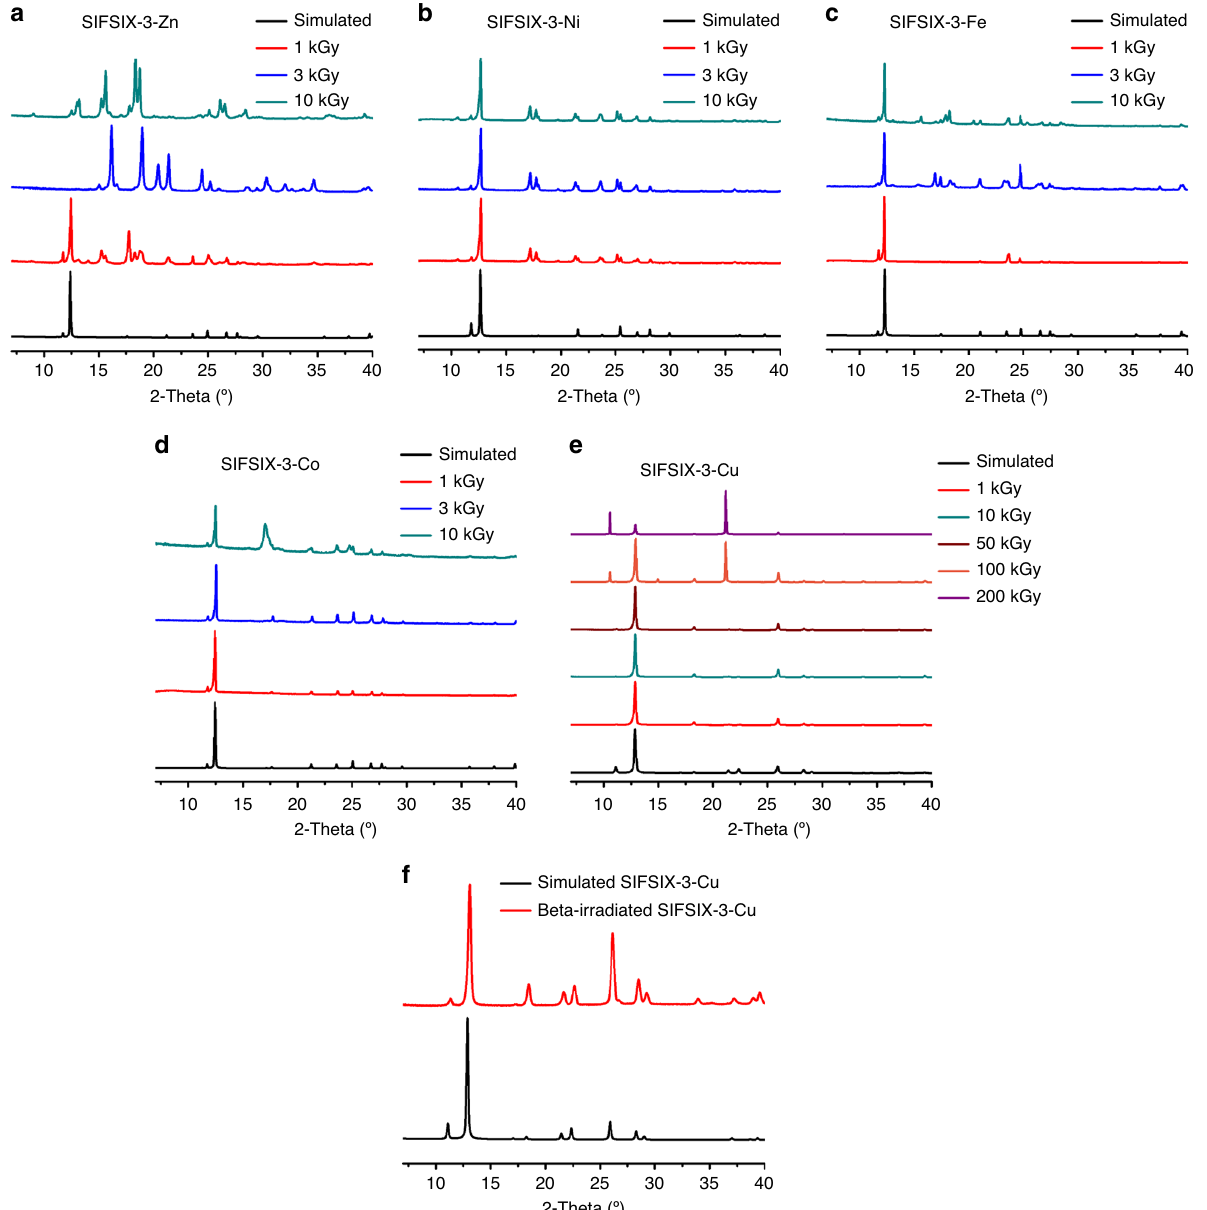
Fig. 3 Powder X-ray diffraction patterns of irradiated and simulated SIFSIX-3-M structures. a gamma-irradiated SIFSIX-3-Zn, b gamma-irradiated SIFSIX-3-Ni, c gamma-irradiated SIFSIX-3-Fe, d gamma-irradiated SIFSIX-3-Co, and e SIFSIX-3-Cu and f activated SIFSIX-3-Cu structure after 50 kGy beta